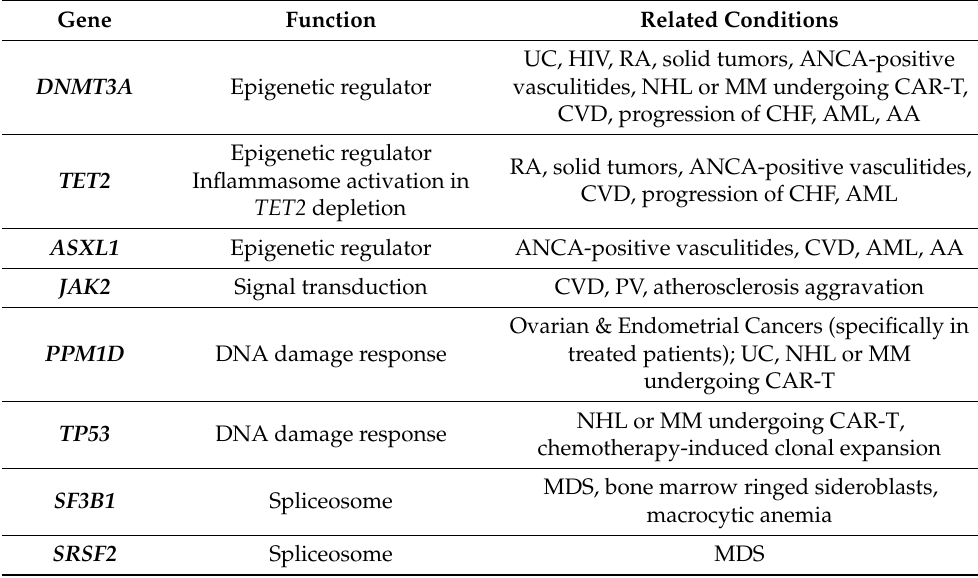
Table 1. Functions of driver mutations involved in CH and other related conditions [10,17,18]. Gene Function Related Conditions UC, HIV, RA, solid tumors, ANCA-positive DNMT3A Epigenetic regulator vasculitides, NHL or MM undergoing CAR-T, CVD, progression of CHF, AML, AA Epigenetic regulator RA, solid tumors, ANCA-positive vasculitides, TET2 Inflammasome activation in CVD, progression of CHF, AML TET2 depletion ASXL1 Epigenetic regulator ANCA-positive vasculitides, CVD, AML, AA JAK2 Signal transduction CVD, PV, atherosclerosis aggravation Ovarian & Endometrial Cancers (specifically in PPM1D DNA damage response treated patients); UC, NHL or MM undergoing CAR-T NHL or MM undergoing CAR-T, TP53 DNA damage response chemotherapy-induced clonal expansion MDS, bone marrow ringed sideroblasts, SF3B1 Spliceosome macrocytic anemia SRSF2 Spliceosome